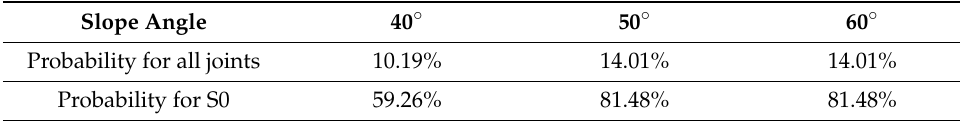
Table 7. Probability of planar sliding along S0 with different slope angles.